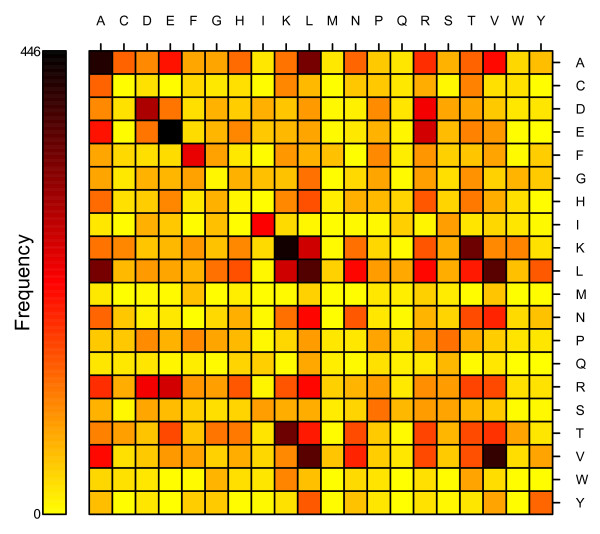
The color-coded representation of the coevolution frequency matrix for all inferred coevolving pairs. The residues are arranged alphabetically.